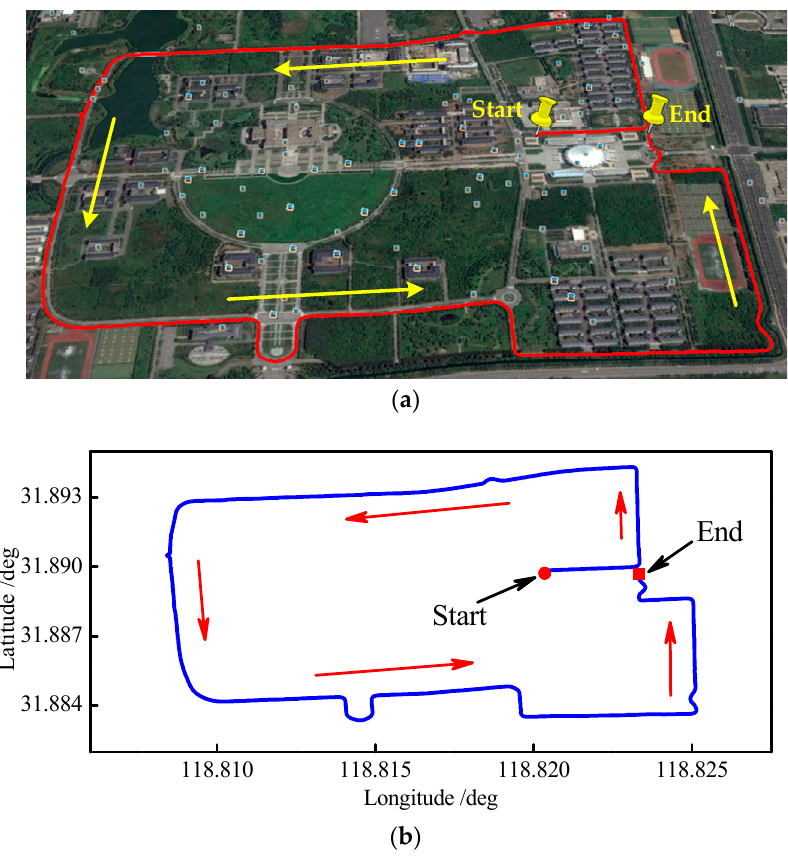
Figure 10. Vehicle trajectory. ( a ) Google map of the reference trajectory; ( b ) coordinates of the reference trajectory.